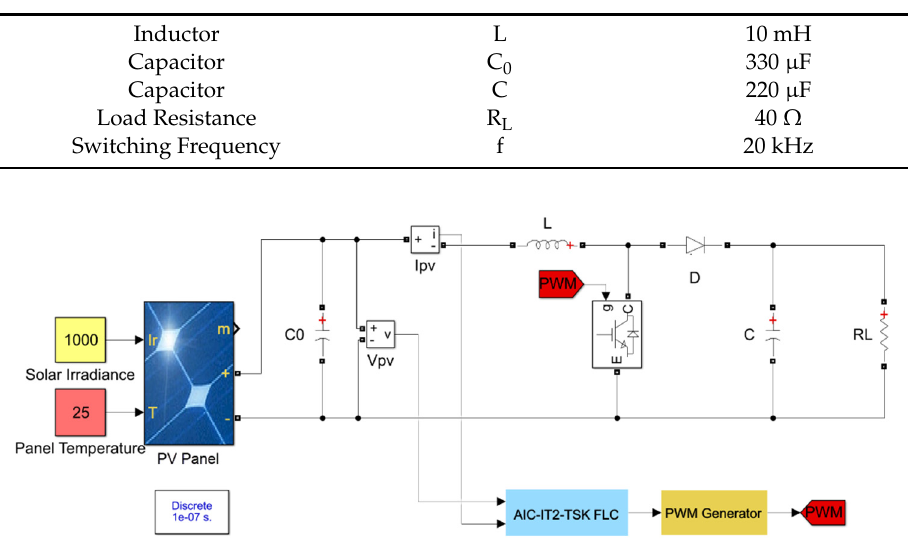
Figure 8. Simulation model. Table 2. Electrical characteristic parameters of a PV panel.